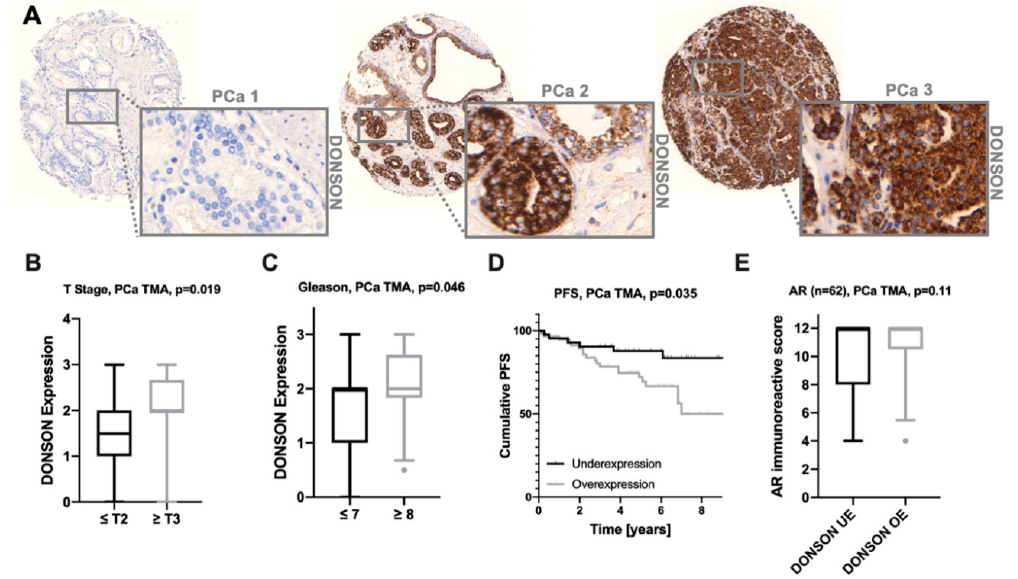
Figure 3. Immunohistochemical staining (IHC) against DONSON on a comprehensive PCa TMA with subsequent expression analysis ( A ), Representative images of the heterogeneous DONSON expression throughout the primary PCa cohort are depicted in three cases; 10× and 40× objective magnification. PCa 1 represents a well-differentiated DONSON-negative carcinoma. PCa 2 + 3